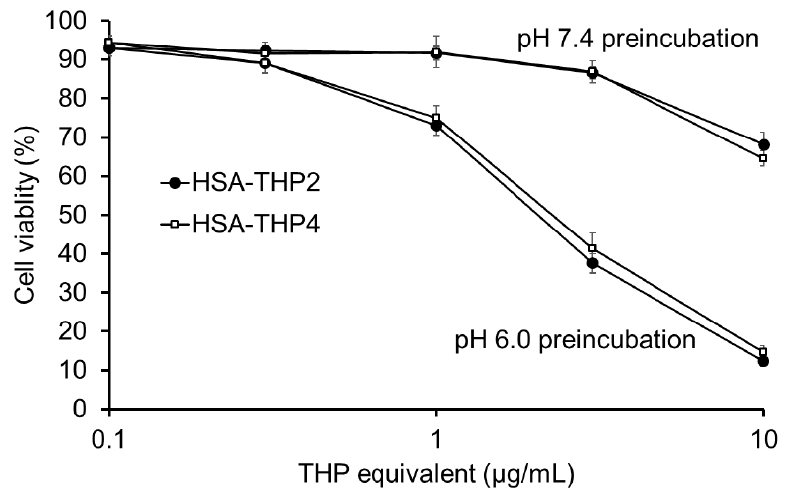
Figure 8. In vitro cytotoxicity of HSA-THP2 or HSA-THP4 against HeLa cells after preincubation in solutions at different pH values. HSA-THP2 or HSA-THP4 was incubated in different buffers pH 7.4 or pH 6.0 for 18 h before being exposed to HeLa cells for 3 h, followed by 48 h of culture. After treatment, MTS Assay was performed to quantify viable cells. Values are the means ± S.E. ( n =